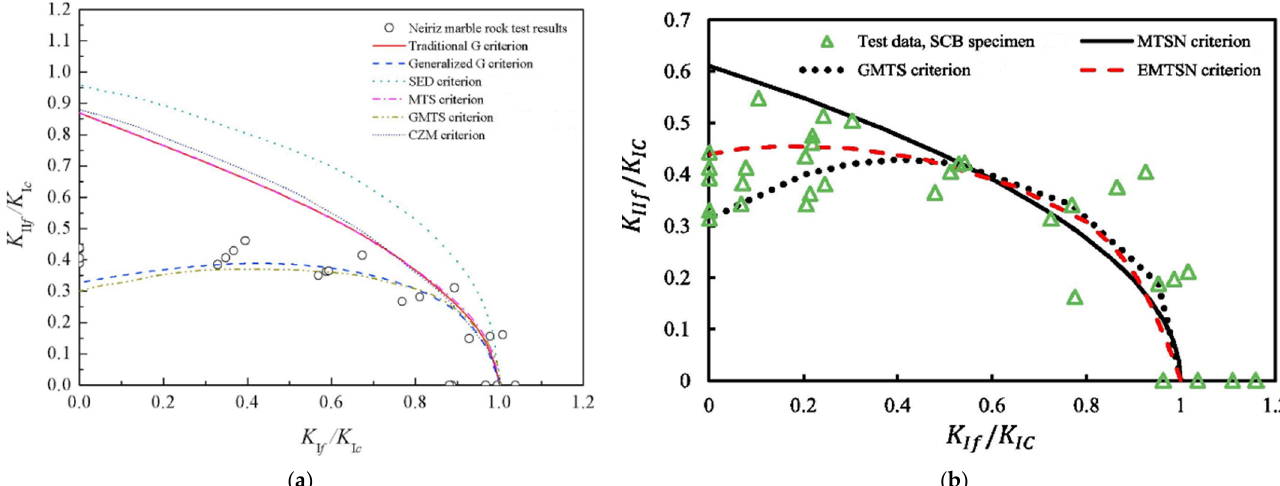
Figure 10. Comparisons of fracture toughness between the theoretical predictions using criteria for mixed fracture and the experimental results. ( a ) ECT specimens of Neyriz marble. Reprinted with permission from Ref. [216]. Copyright 2018, Elsevier. ( b ) SCB specimens of Neyriz and Harsin marble. Reprinted with permission from Ref. [213]. Copyright 2017, Elsevier.